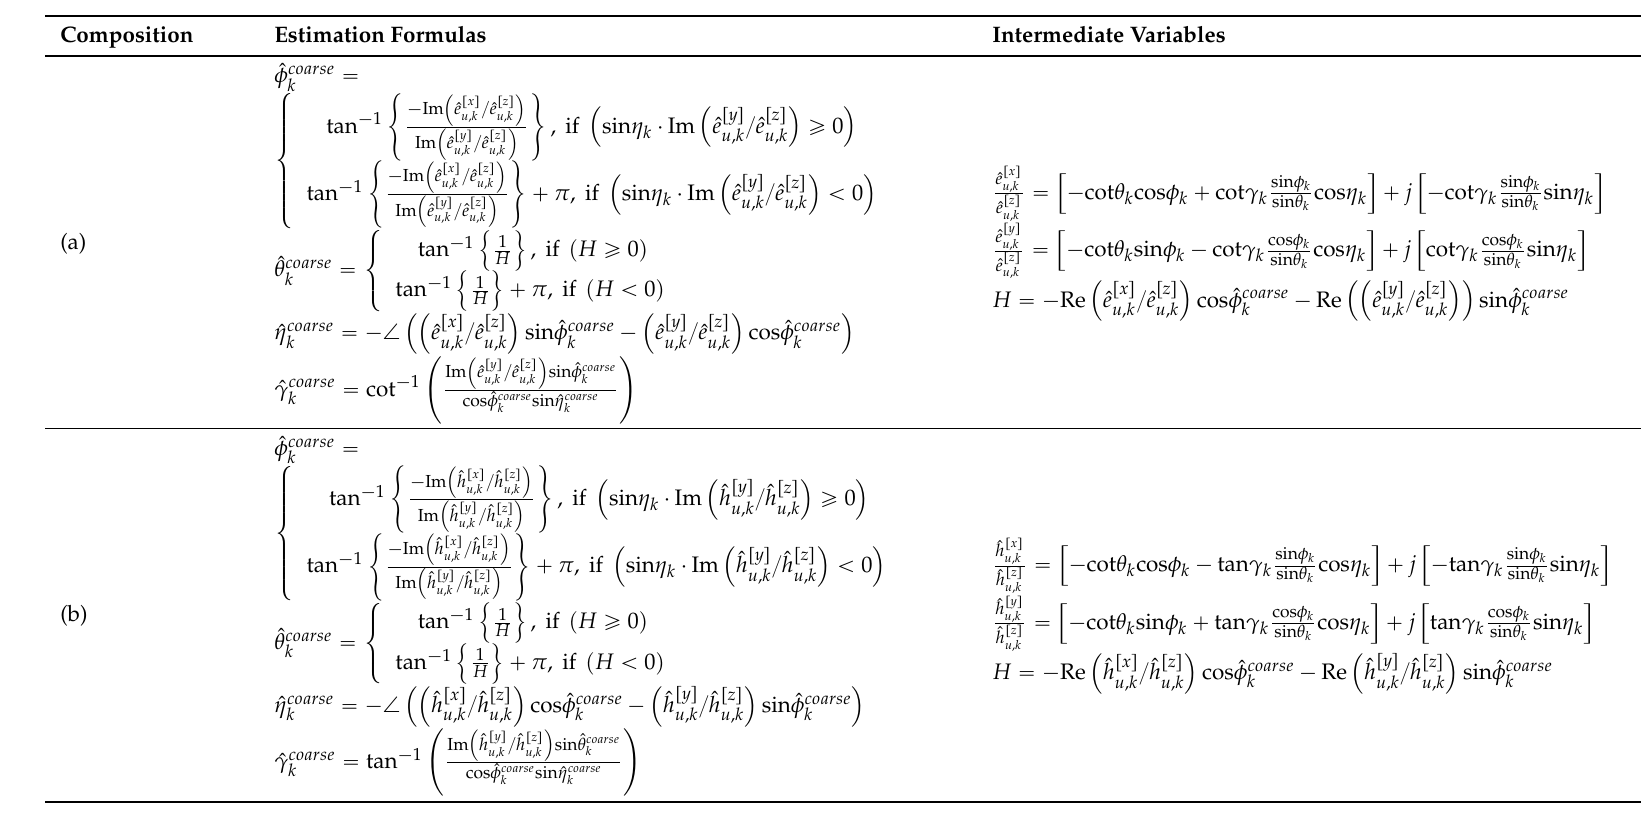
Table 1. Coarse estimates of uncorrelated sources for four different antenna